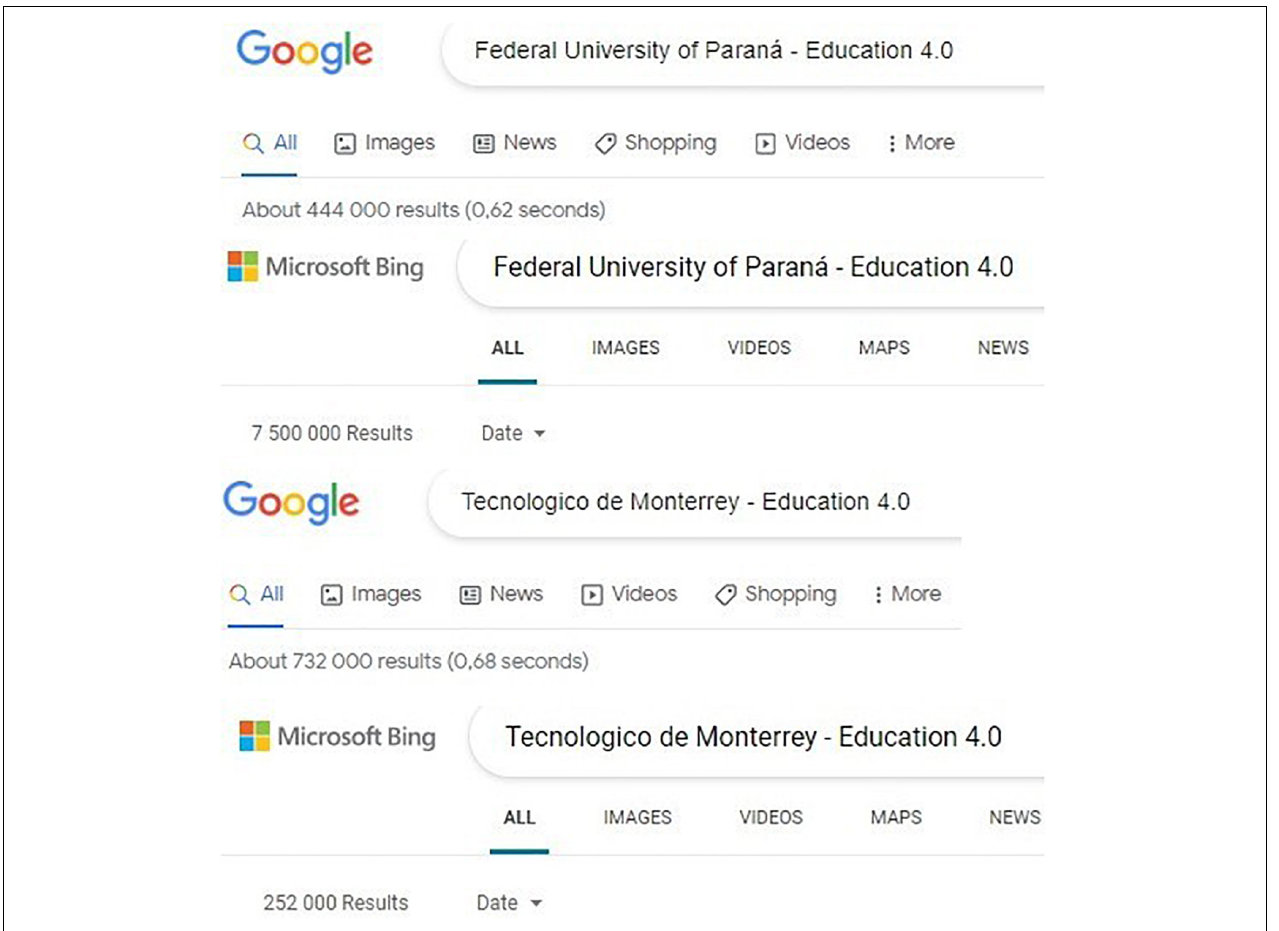
FIGURE 3 | Google and Bing search results for two